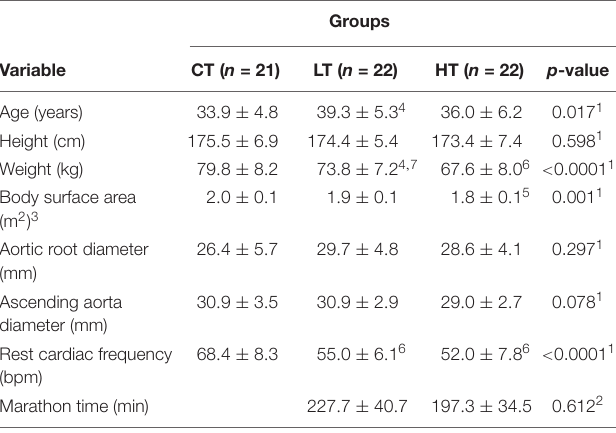
TABLE 1 | Participant’s characteristics.